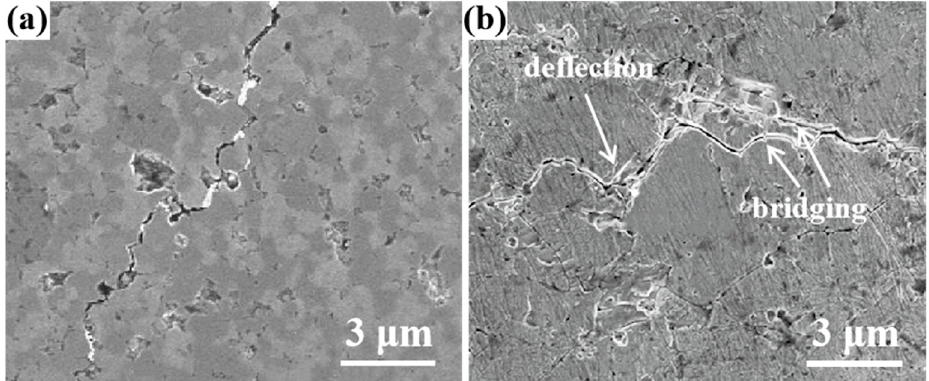
Figure 6. High magnification finite element scanning electron microscope image. ( a ) Picture of crack deflection in TiC-50 vol.% SiC, ( b ) Picture of crack deflection in TiC-3.5 wt.% WC.